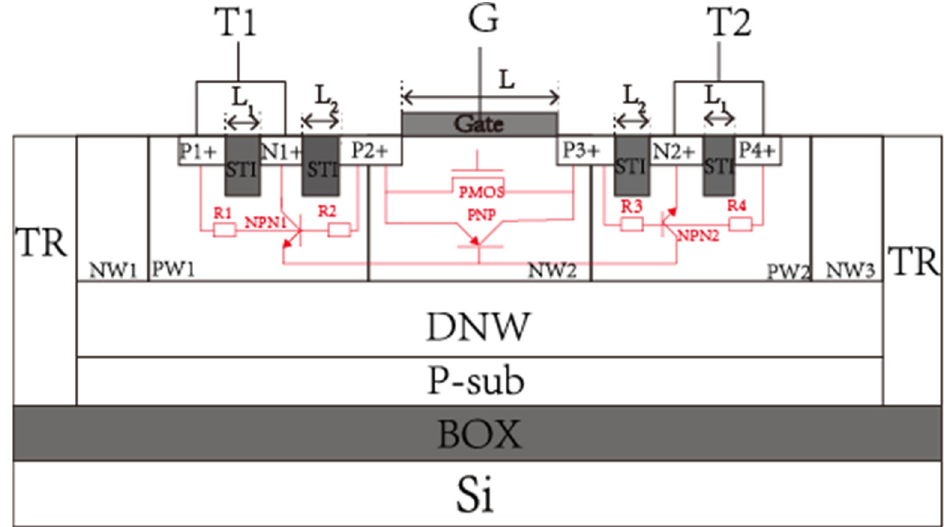
Figure 1. Cross-sectional view and equivalent circuit of the PTBSCR in SOI BCD technology. Table 1. Some parameters of PTBSCR.